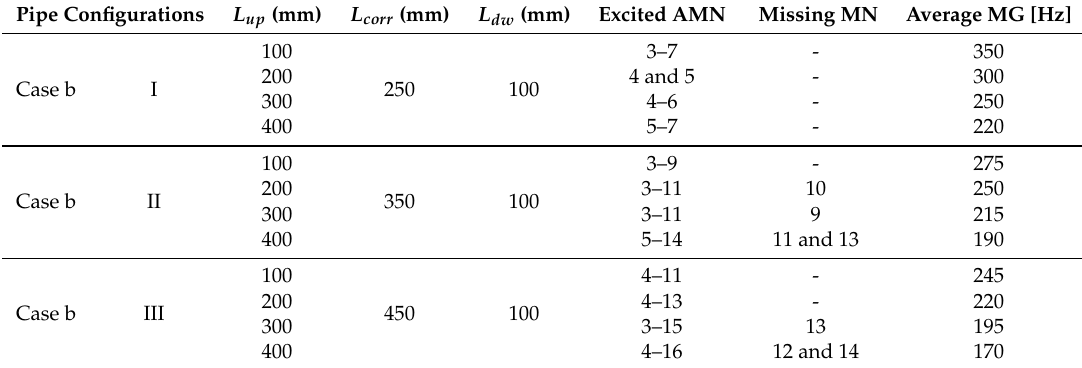
Table 20. Excited acoustic mode numbers, mode numbers within the whistling range at which there was no whistling, and average mode gap between two successive modes for all configurations included in Case